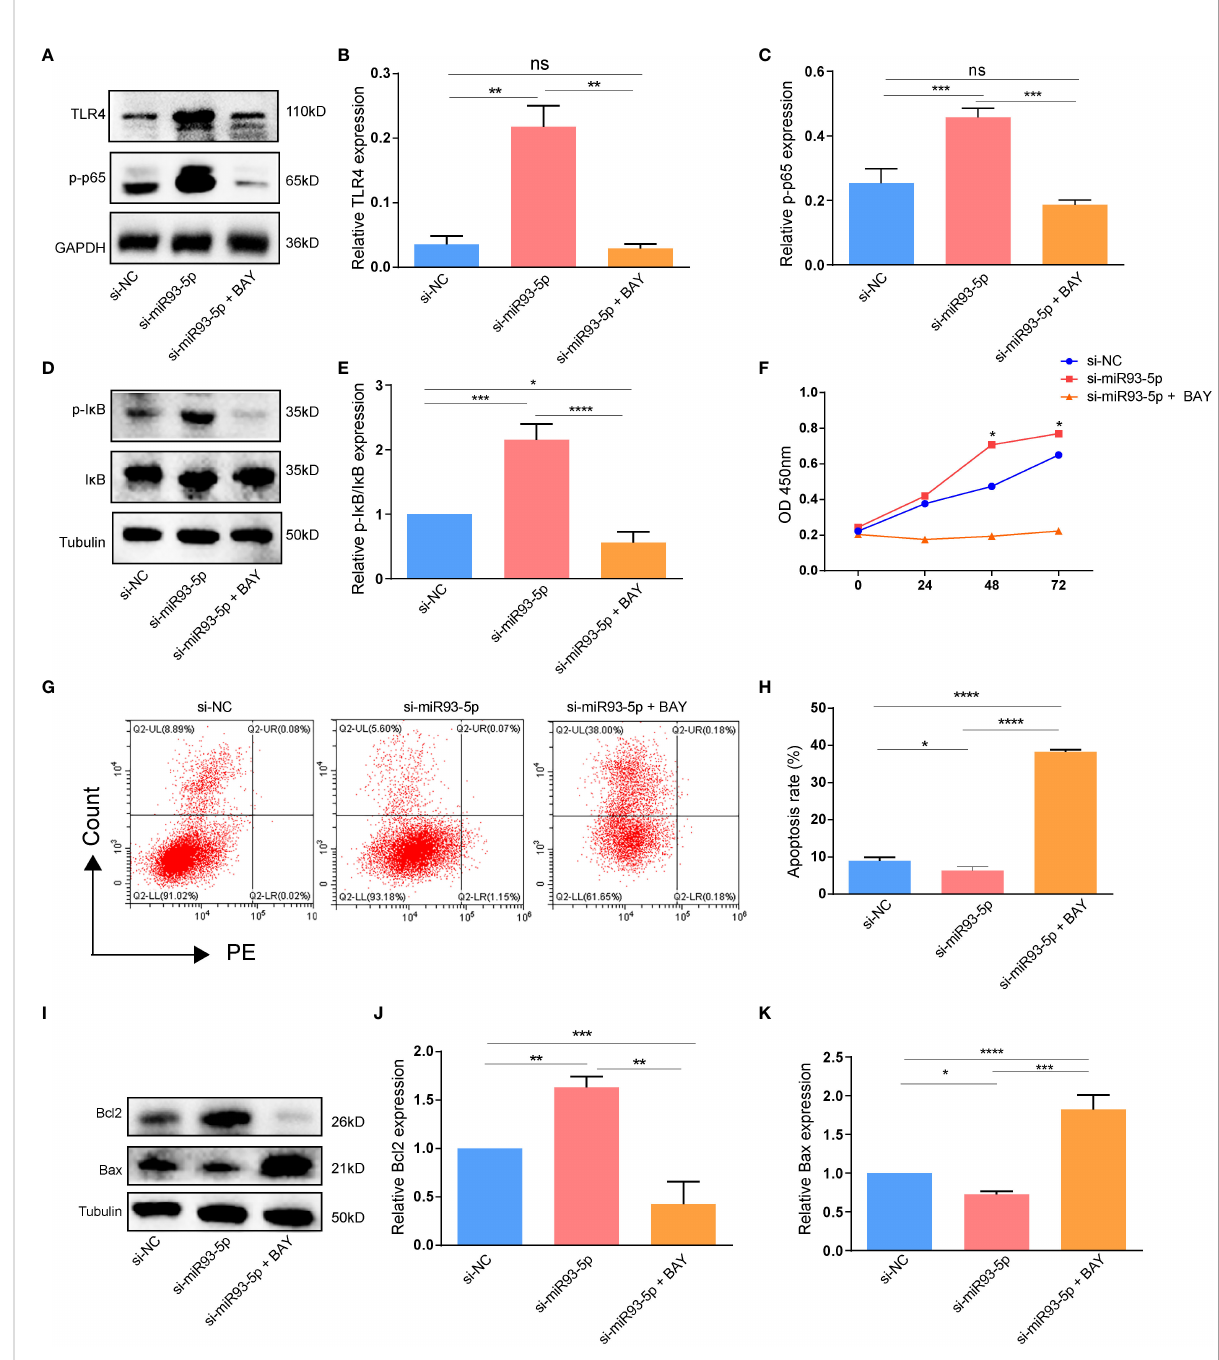
FIGURE 8 The effect of the NF- k B signaling pathway on the apoptosis. (A – E) WB demonstrated that the expression of TLR4, p-p65 and p-I k B/I k B were signi fi cantly inhibited by NF- k B inhibitor (BAY 11-7082). (F) The cell viability among three groups. (G, H) Flow cytometry assay showed that there was an increased apoptosis level in the si-miR93-5p + BAY group. (I – K) The protein expression of Bax and Bcl-2 among three groups. p < 0.05 ( “ * ” ), p < 0.01 ( “ ** ” ), p < 0.001 ( “ *** ” ), p < 0.0001 ( “ **** ”